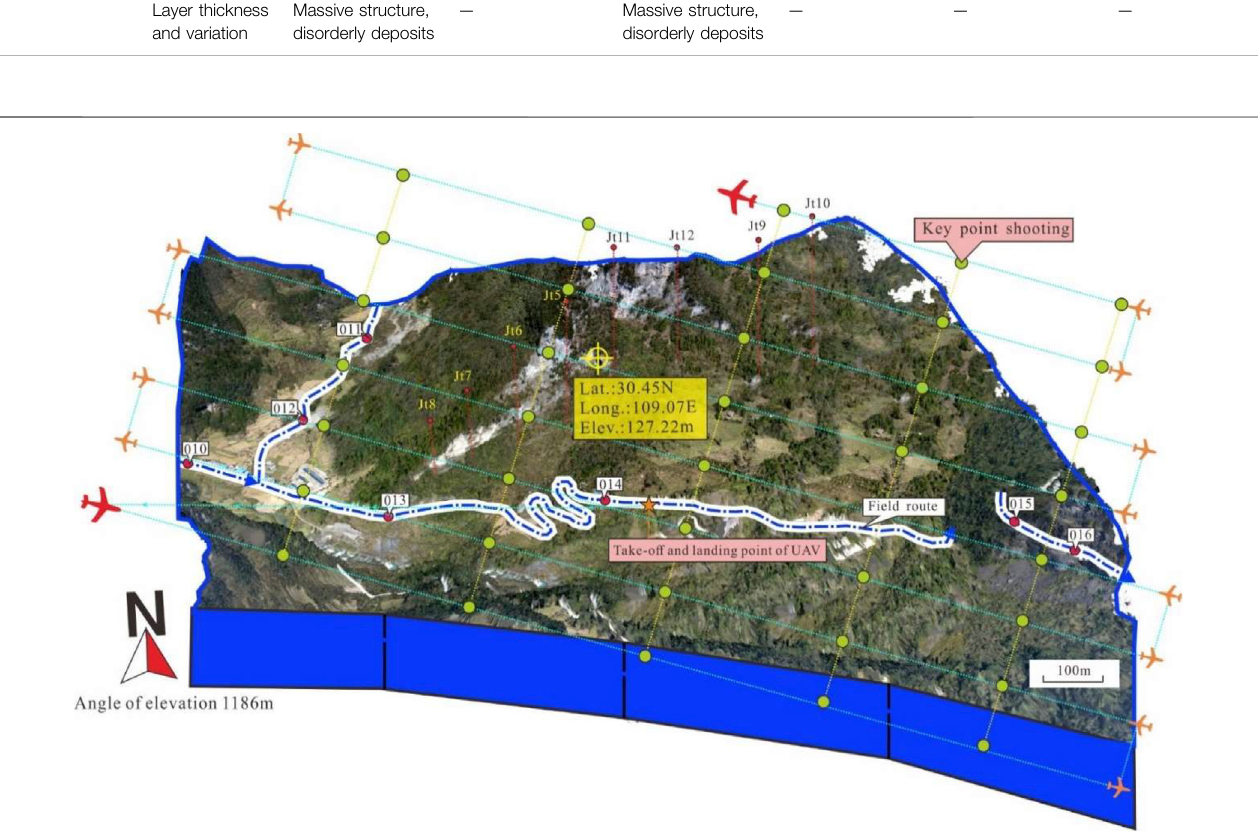
FIGURE 8 | 3D digital outcrop model processed by UAV oblique photography, outcrop of Jiantianba. The maximum resolution of a local image was ~10 – 20 cm. Cruise line automatic set-up by POS system. The UAV take off from start point to the end then achieved outcrop scanning and taking pictures.